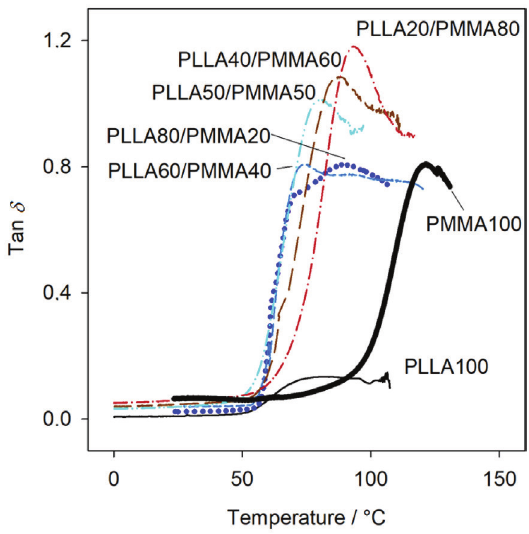
Fig. 12 – Dynamic storage modulus of pure PLLA, PMMA, and PLLA/PMMA blends as a function of temperature